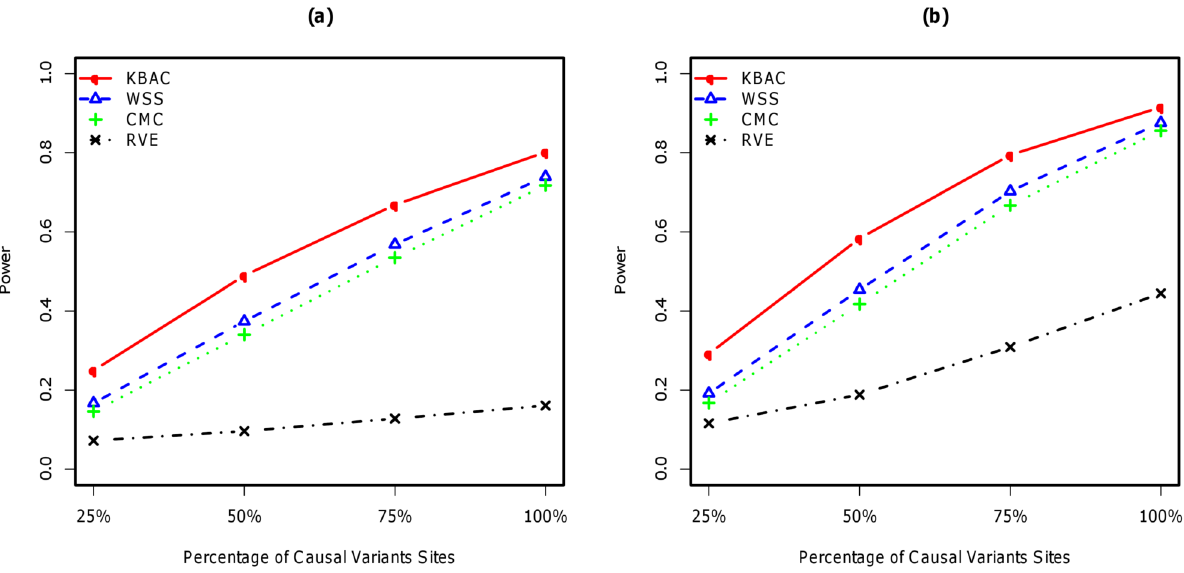
Figure 4. Power comparisons for within gene (left panel) and between gene interaction model (right panel) with simulated SFS for AA. Power was evaluated for the KBAC, WSS, CMC and RVE. A sample size of 1000 cases and 1000 controls were used for the within interaction model, and a sample size of 300 cases and 300 controls were used for the between gene interaction model. Scenarios with different proportions of causal variants were considered. P-values were empirically estimated using 5,000 permutations and power was evaluated for a significance level of a ~ 0 : 05 using 2,000 replicates.